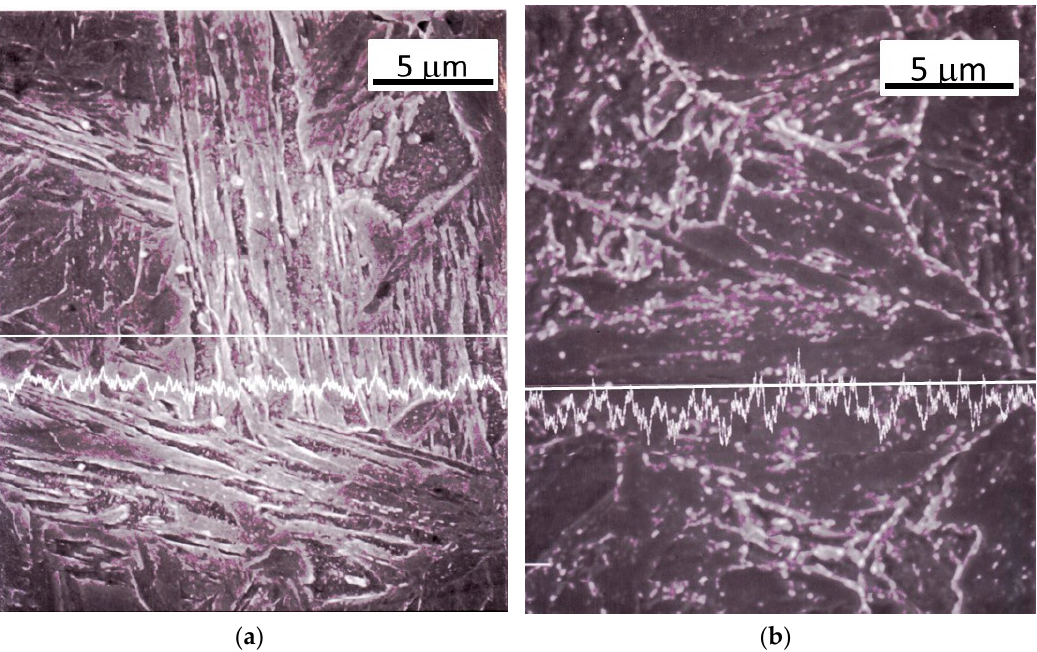
Figure 4. Structure of the steel as-quenched ( a ) and after the heat treatment at 700 °C for 10 h ( b ).